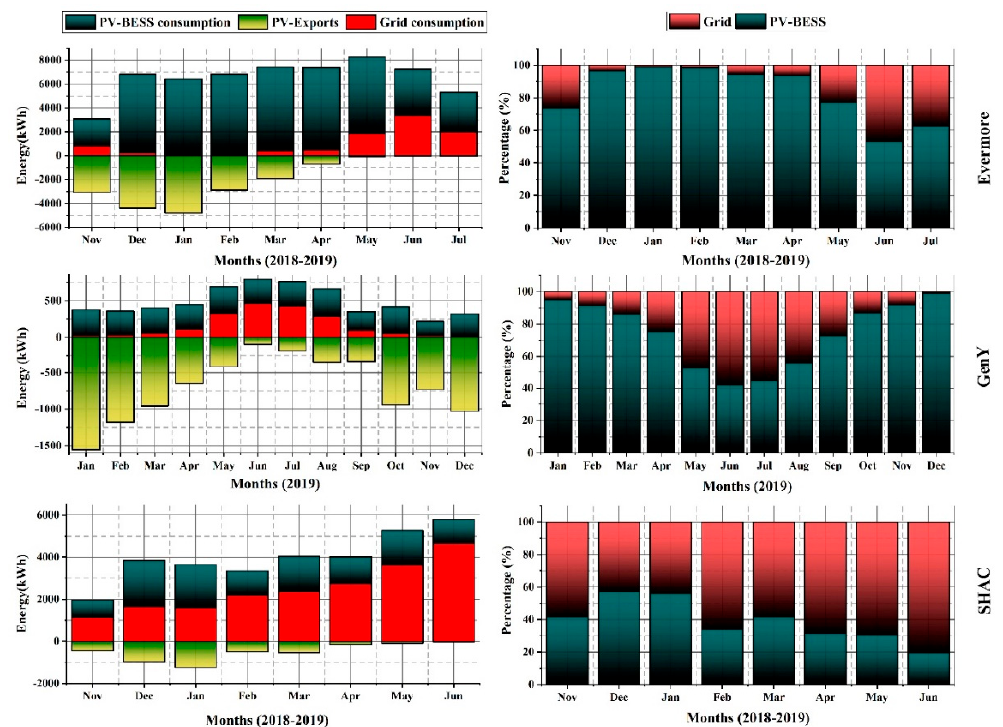
Figure 8. ( left ) Monthly energy distribution and PV exports ( right ) resultant self-sufficiency.